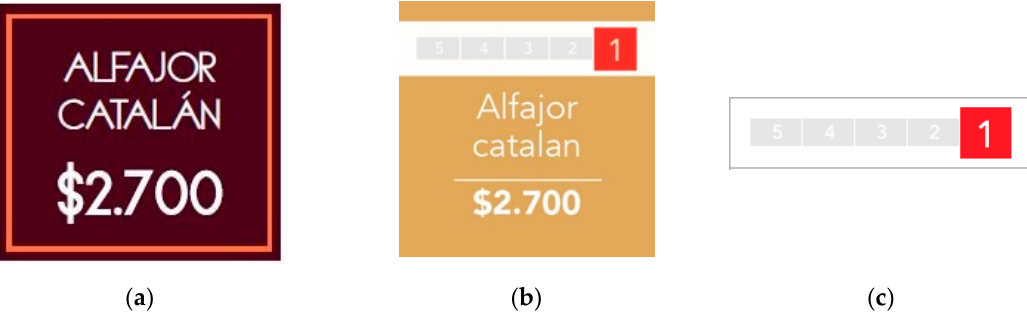
Figure 2. Price tags inside the cafeteria stands before and during intervention. ( a ) Price tags before intervention; ( b ) modified price tags during intervention, which have a color and number scale that changes depending on the nutritional information of the product; ( c ) stickers for sticking onto pre-packaged products, which also have a color and number scale that changes depending on the nutritional information of the product. Notice that there is no reference to the Nutri-Score system in any of the price tags. Figures are not to scale.